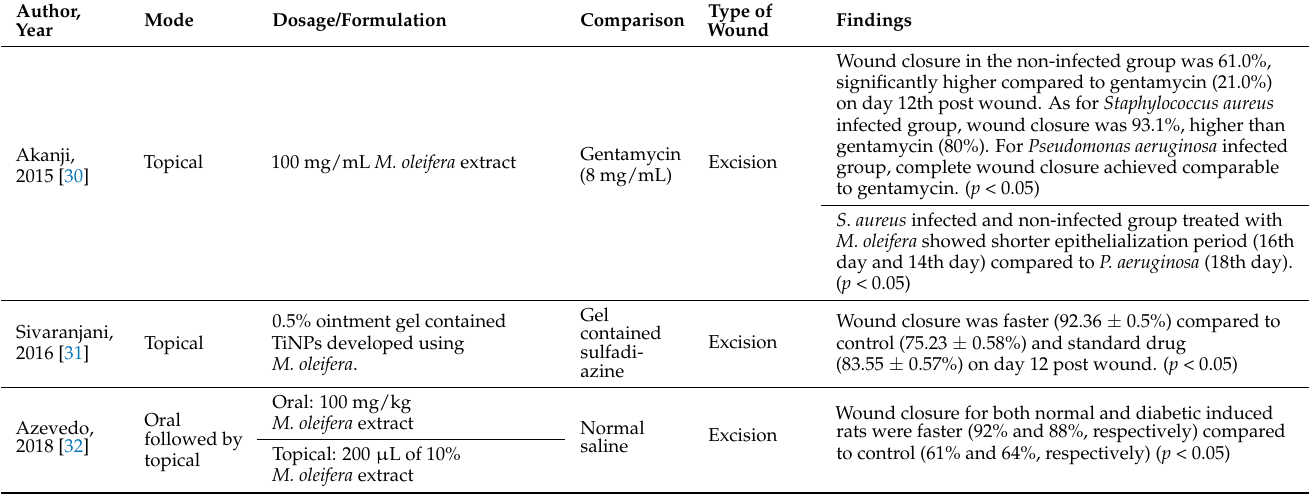
Table 2. Data extraction table on wound healing